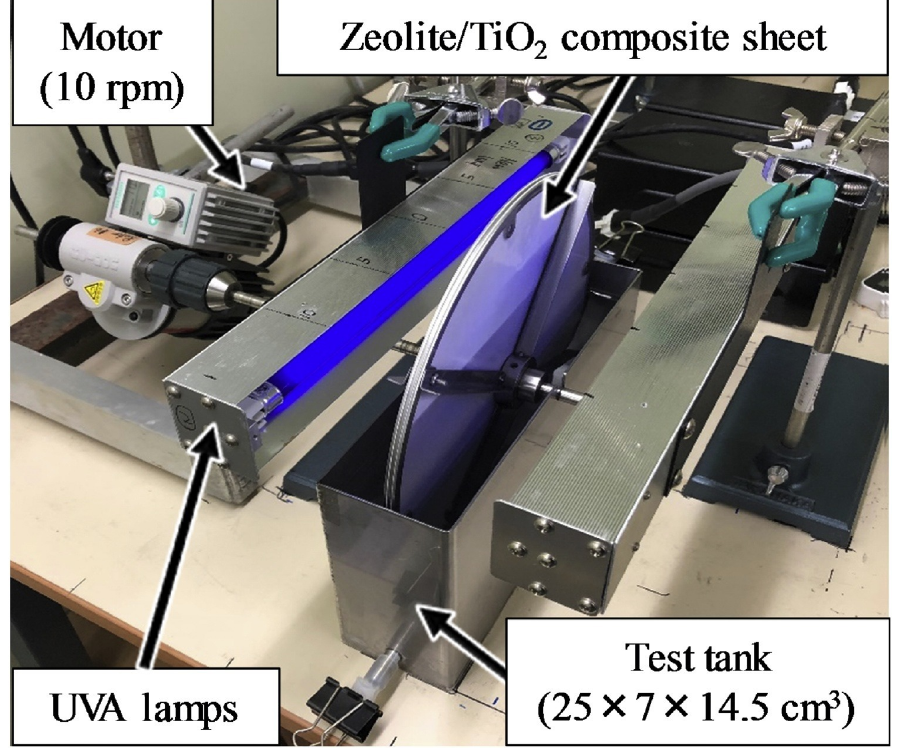
Figure 9. Rotating advanced oxidation contactor (RAOC) equipped with zeolite/TiO 2 composite sheets (reproduced with permission of [150]).